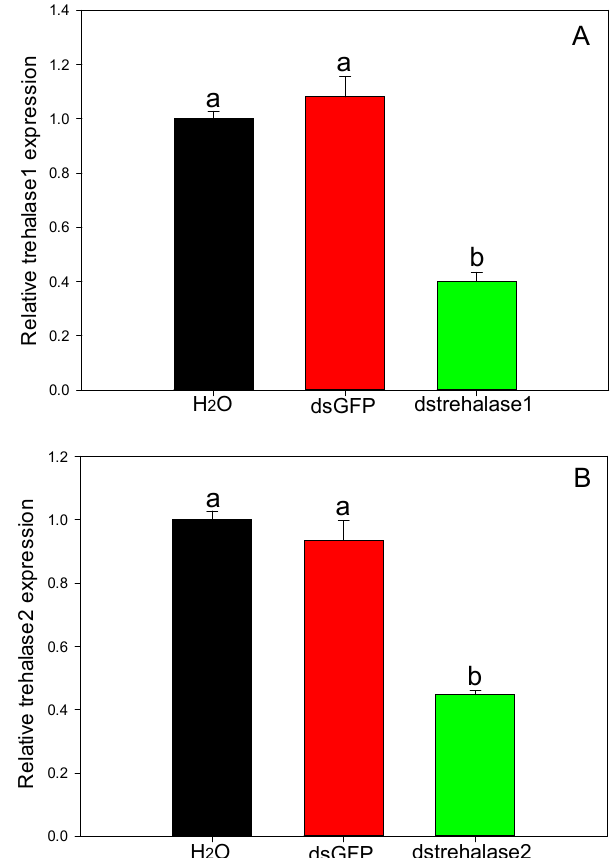
Figure 9. Relative gene expression in D. citri 2nd instars after treatment with specific double-stranded RNA (dsRNA). Trehalase 1 ( A ) and trehalase 2 ( B ). The 2nd instars were treated with trehalase1-specific dsRNA (dstrhalase1), trehalase2-specific dsRNA (dstrhalase2), control green fluorescent protein-specific dsRNA (dsGFP), or water (H 2 O) and the gene expression levels were measured. Values shown are means + SE. Different letters indicate significant differences among treatments ( p < 0.05, Tukey’s multiple comparisons test).